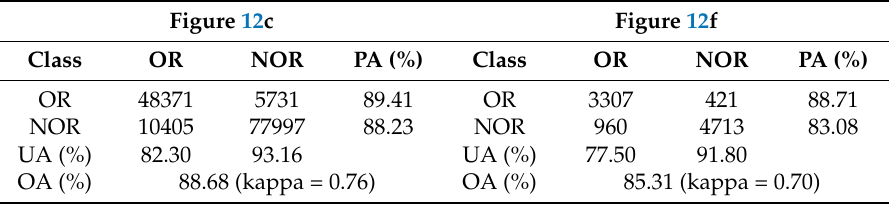
Figure 12. ( a ) Google Earth-derived oilseed rape map, ( b ) CSRA-derived oilseed rape map, and ( c ) spatial comparison between ( a ) and ( b ) at part of Qianjiang City in 2015. ( d ) Google Earth-derived oilseed rape map, ( e ) CSRA-derived oilseed rape map, and ( f ) spatial comparison between ( d ) and ( e ) in part of Wuxue City in 2016. Table 3. Confusion matrix of local accuracy assessment using Google Earth images. Figure 12c Figure 12f